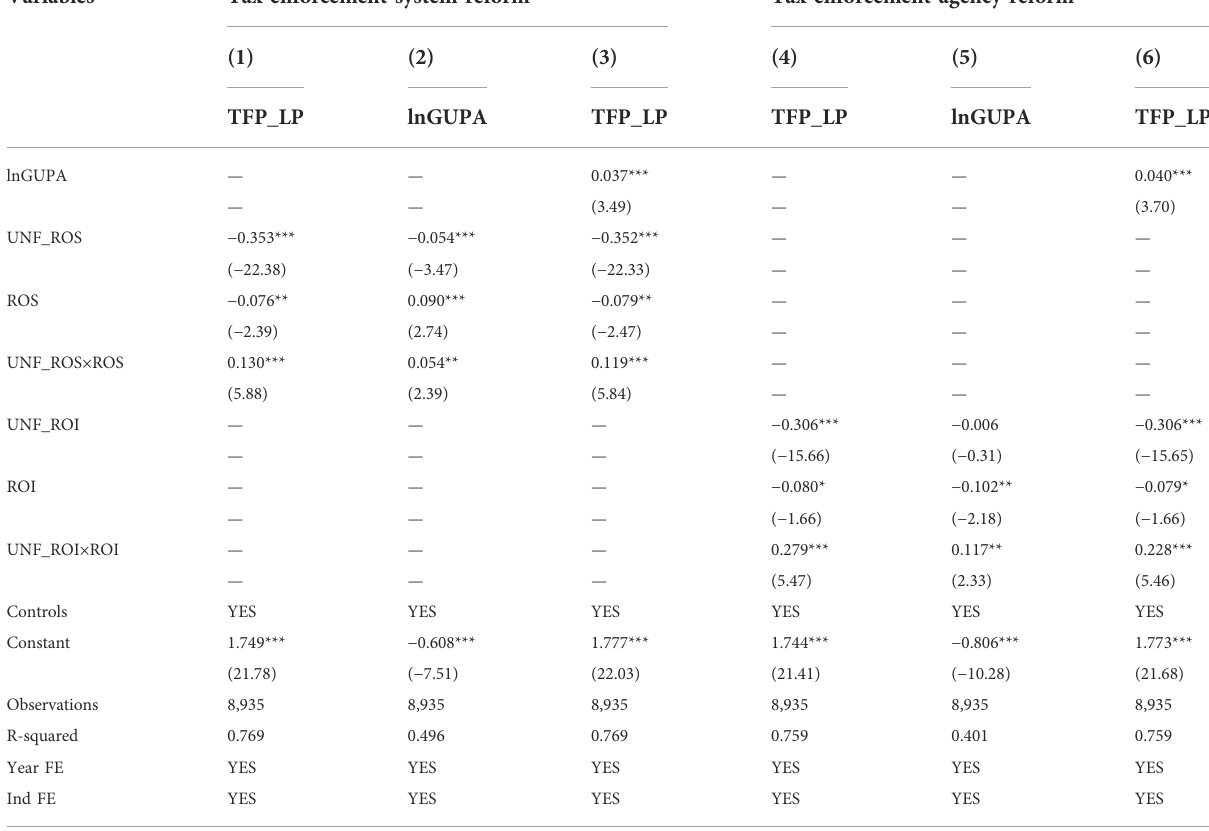
TABLE 10 Mediating mechanism of green utility model patent